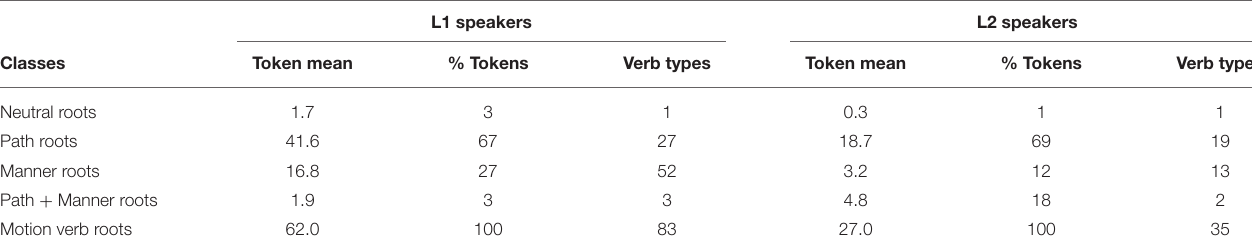
TABLE 3 | Different verb classes in L1 and L2 narratives.